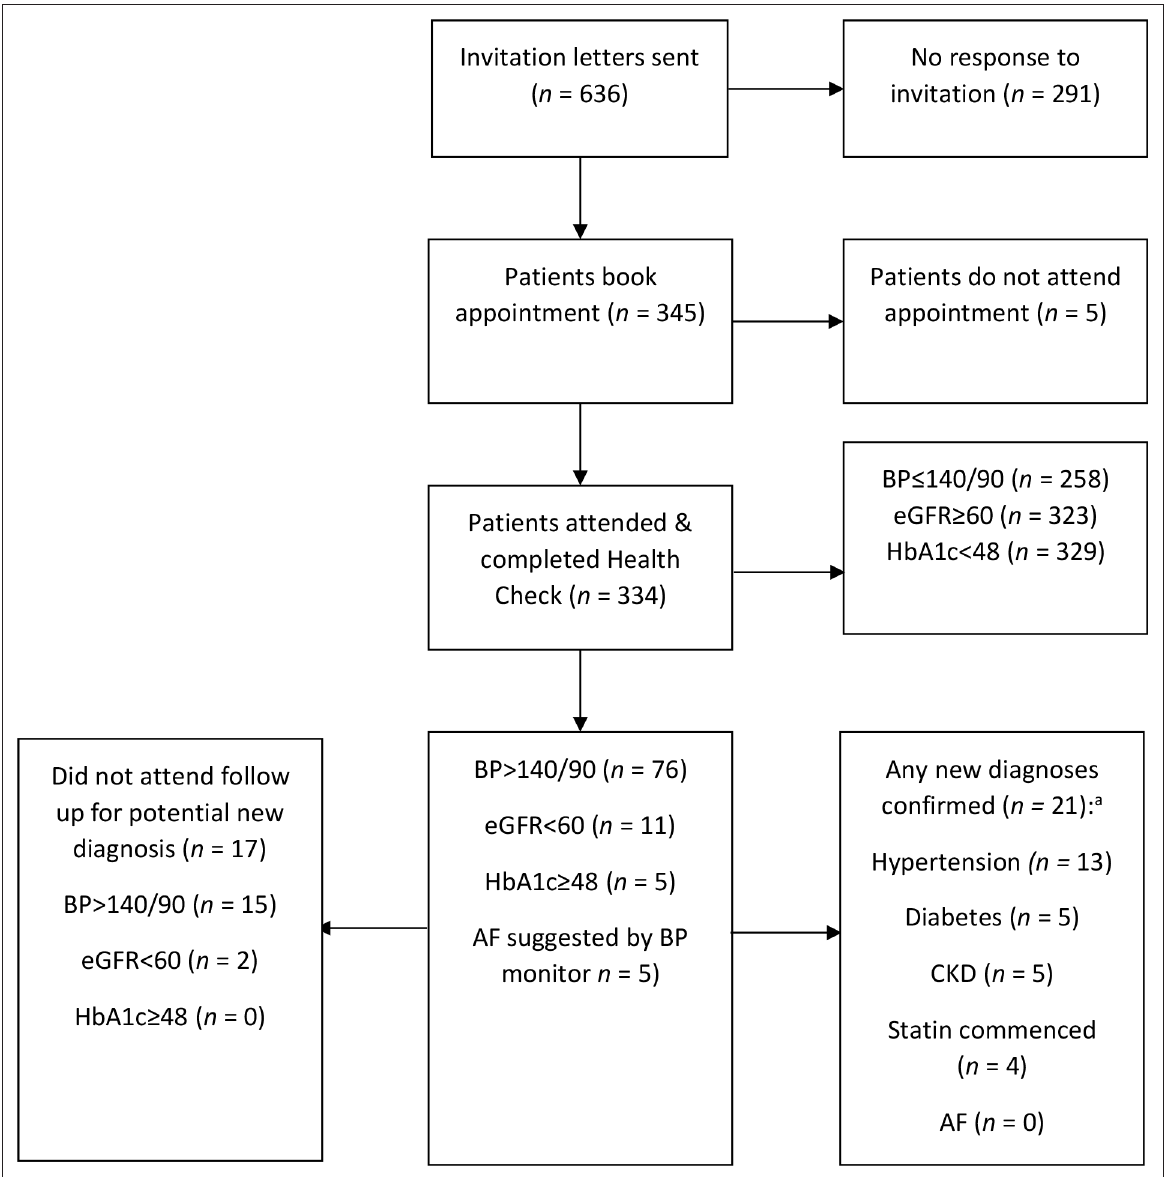
Figure 1 Flow of participants through the health- check protocol during the study. AF = atrial fibrillation. BP = blood pressure. CKD = chronic kidney disease. eGFR = estimated glomerular filtration rate. HbA1c = haemoglobin A1c. a There were 23 new diagnoses in 21